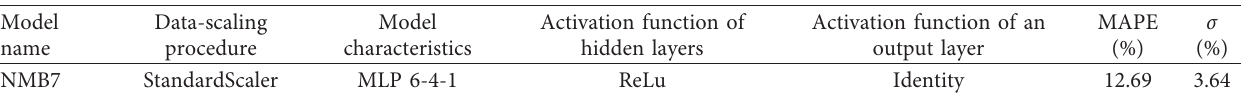
Table 9: Artificial neural network models with random data choice for estimating concrete consumption ( k -fold cross-validation, k � 10). Model